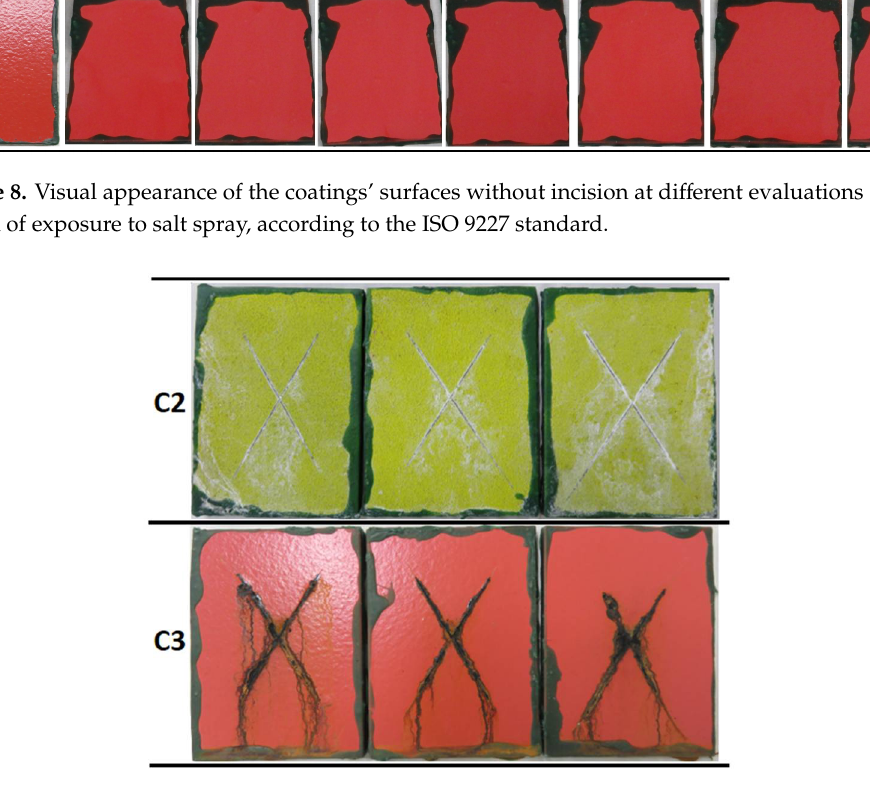
Figure 9. Visual appearance of the coatings surface without incision at different evaluations during 1440 h of exposure to salt spray, according to the ISO 9227 standard.